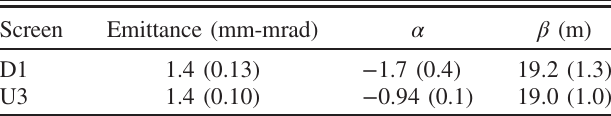
TABLE V. Comparison of single bunch emittance measurement on screen U3 and D1.